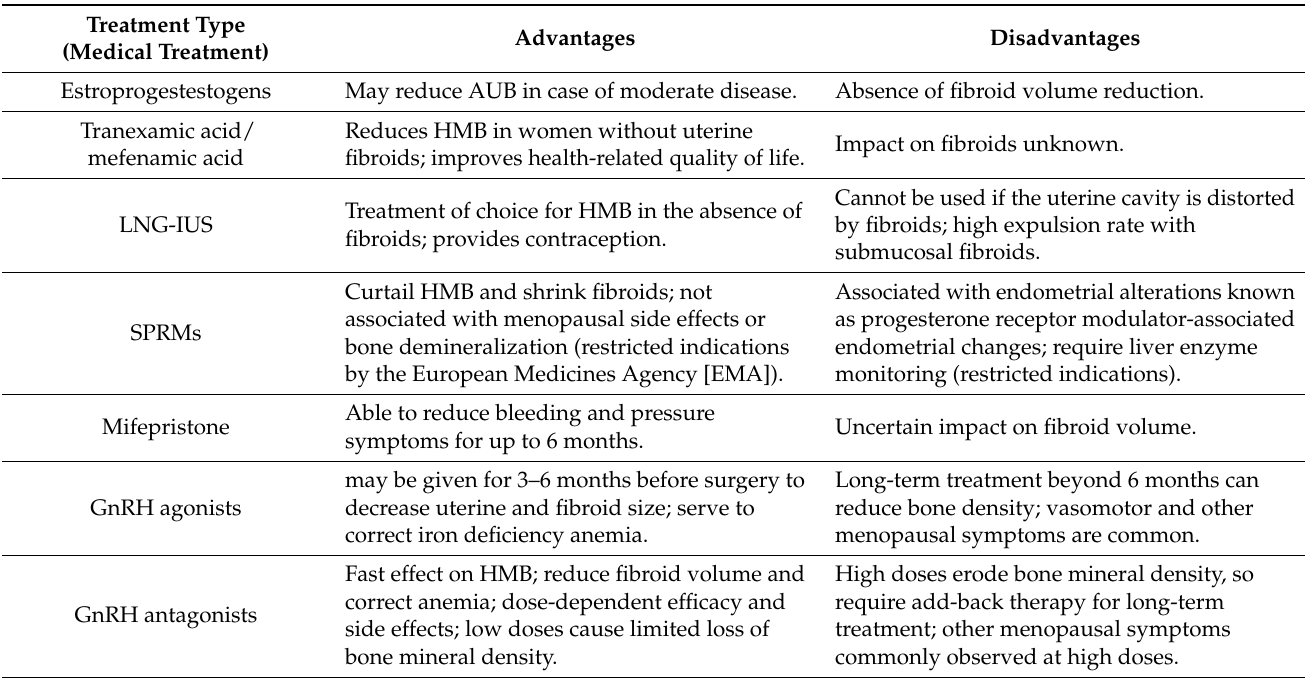
Table 1. Advantages and disadvantages of various medical therapies for intramural myomas. Treatment